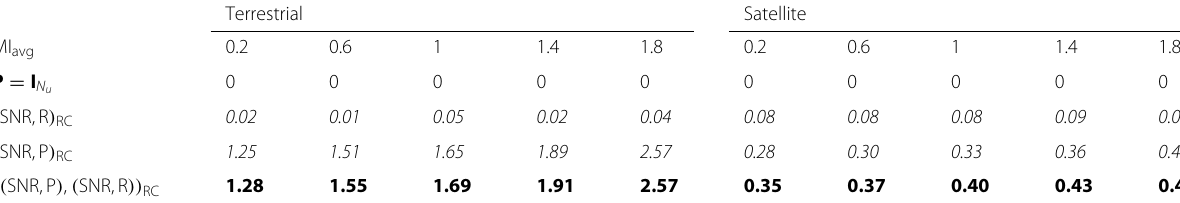
Table 6 SNR gain (dB) of the CD for 4-PAM